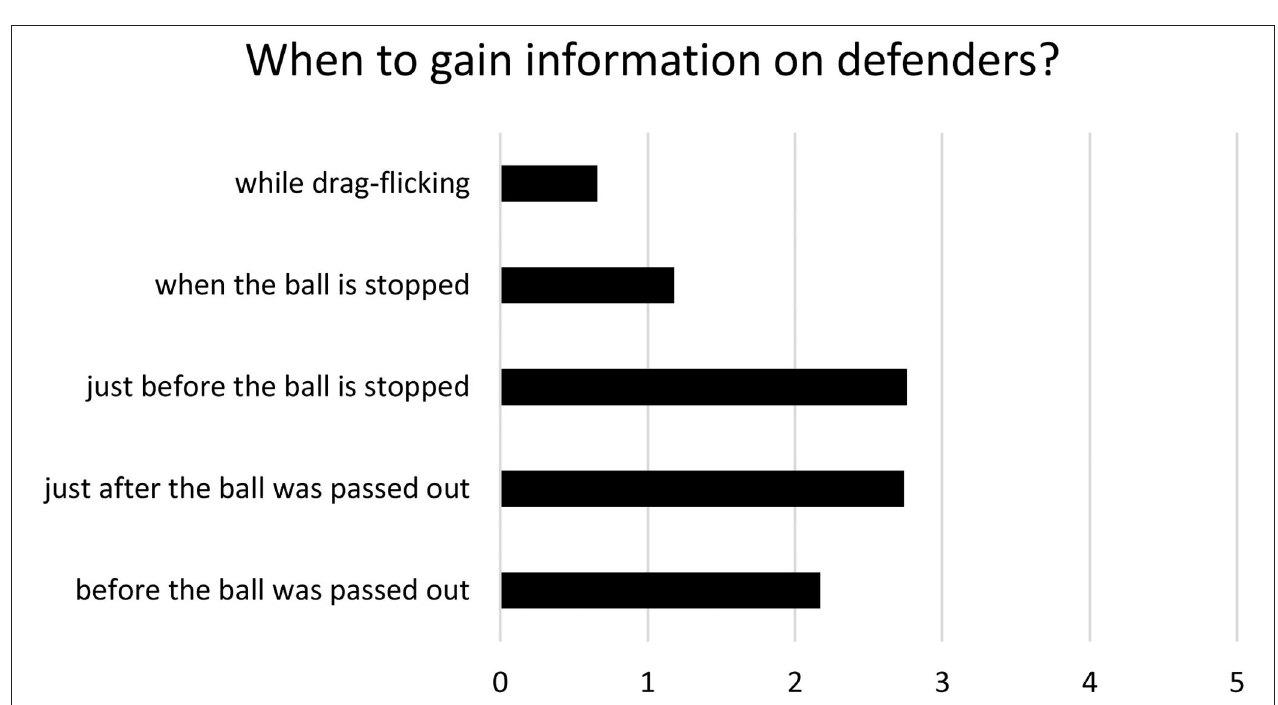
FIGURE 2 | Hockey players’ opinion on when it is reasonable to acquire information on the defenders’ run-out behavior/formation during penalty corners on a five-point-scale (1 = not possible/reasonable at all, 5 = very well possible/reasonable) in order to react to it by choosing a well-matching offensive